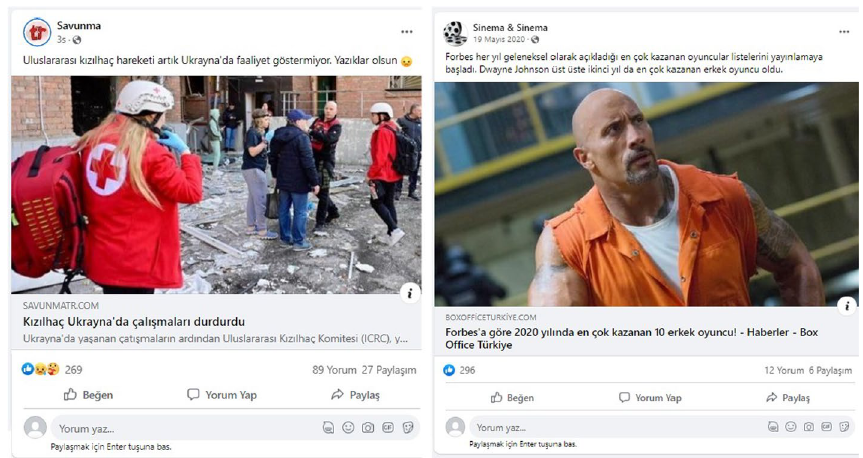
Fig. 1 Examples of FN items (on the left) and real news items (on the